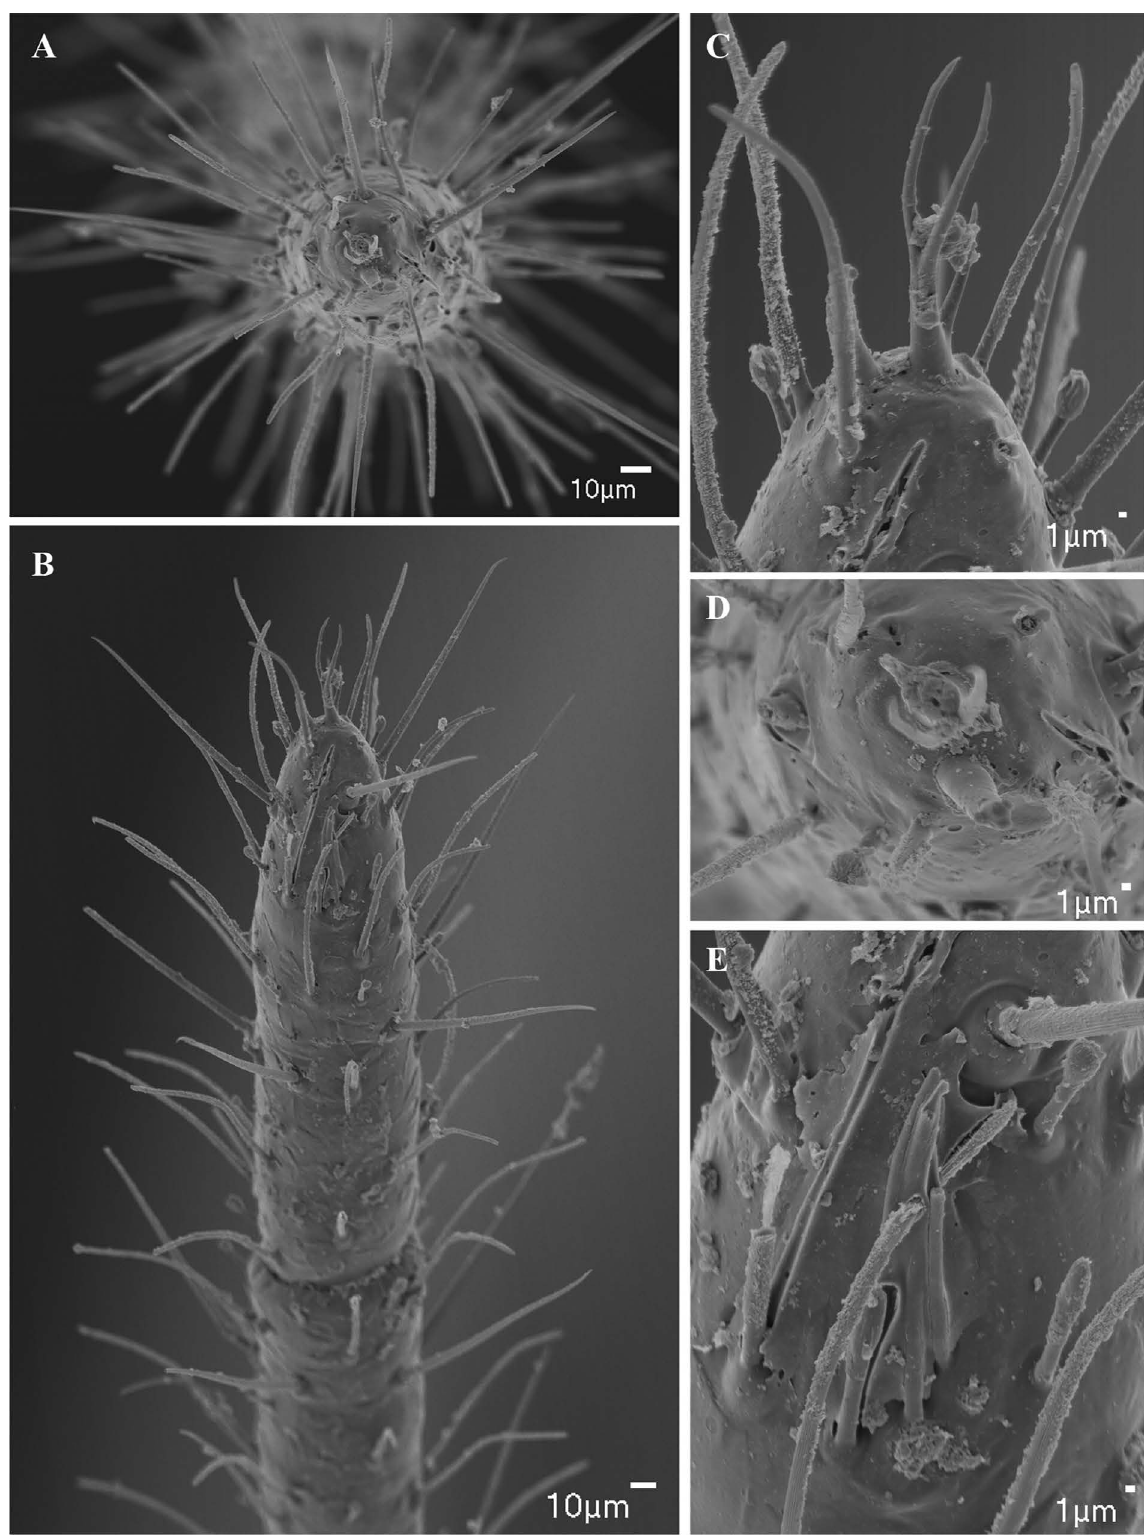
Fig. 26. Charinus miskito sp. nov. (SMNS), antenniform leg I, ♂. A . Apex of distal article. B . Distal segment of tarsus, lateral view. C . Apex of distal article of tarsus showing claw and tarsal organ. D . Detail of claw tarsal organ. E . Rod sensilla and olfactory